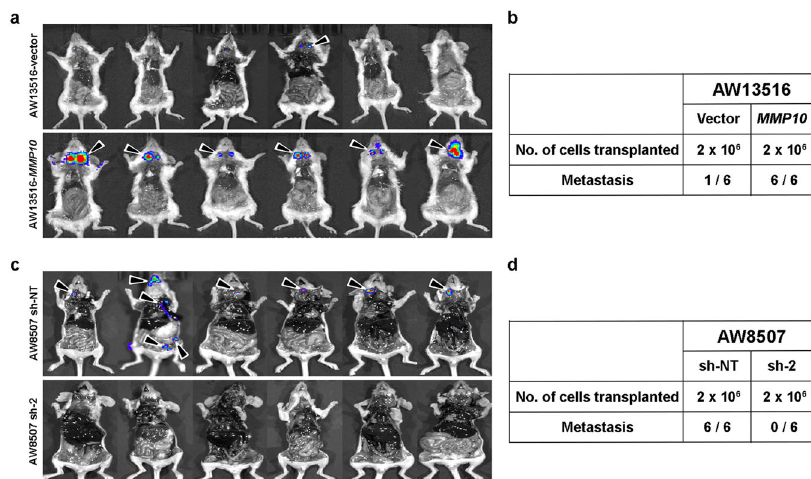
Fig. 5 MMP10 promotes metastases of tongue cancer in vivo. a , c IVIS imaging for detection of metastasis in mice injected ( n = 6/group) with AW13516 cells stably overexpressing empty vector or MMP10 ( a ) and AW8507 cells with sh-NT or MMP10 knockdown ( c ). Bioluminescence imaging was performed after the resection of primary tongue tumors from the mice. The black arrowhead indicates the metastasis in regional lymph nodes and distant organs. b , d Tabular representation of the number of cells injected orthotopically into the tongue of mice and number of mice with metastasis in regional lymph nodes or distant